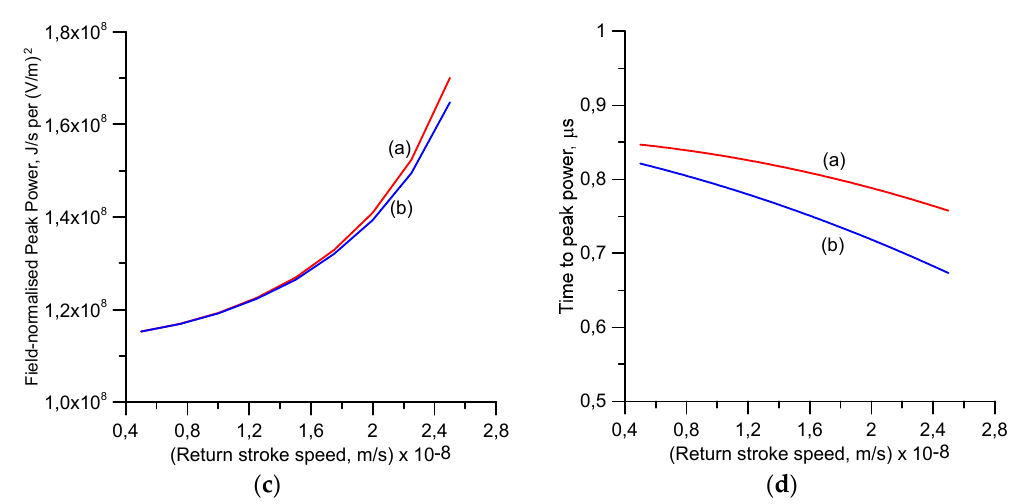
Figure 10. Data pertinent to the peak power radiated by a subsequent return stroke supporting a channel base peak current of 12 kA. ( a ) The range-normalized (to 100 km) peak radiation field at ground level as a function of the return stroke speed; ( b ) The peak power generated by the return stroke as a function of the return stroke speed; ( c ) The field-normalized peak power obtained by dividing the peak power by the square of the radiation field peak at 100 km; ( d ) The time at which the power peaks as a function of the return stroke. (a) MTLL model; (b) MTLE model.